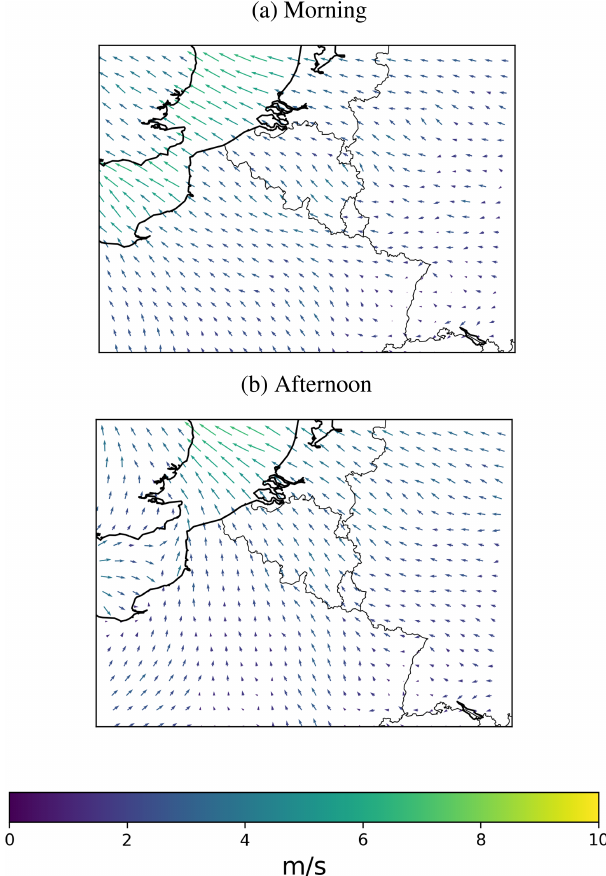
Figure 2. Morning (a) and afternoon (b) wind averaged in the first two vertical layers of the CHIMERE grid (i.e. heights between 0 and 28m above the